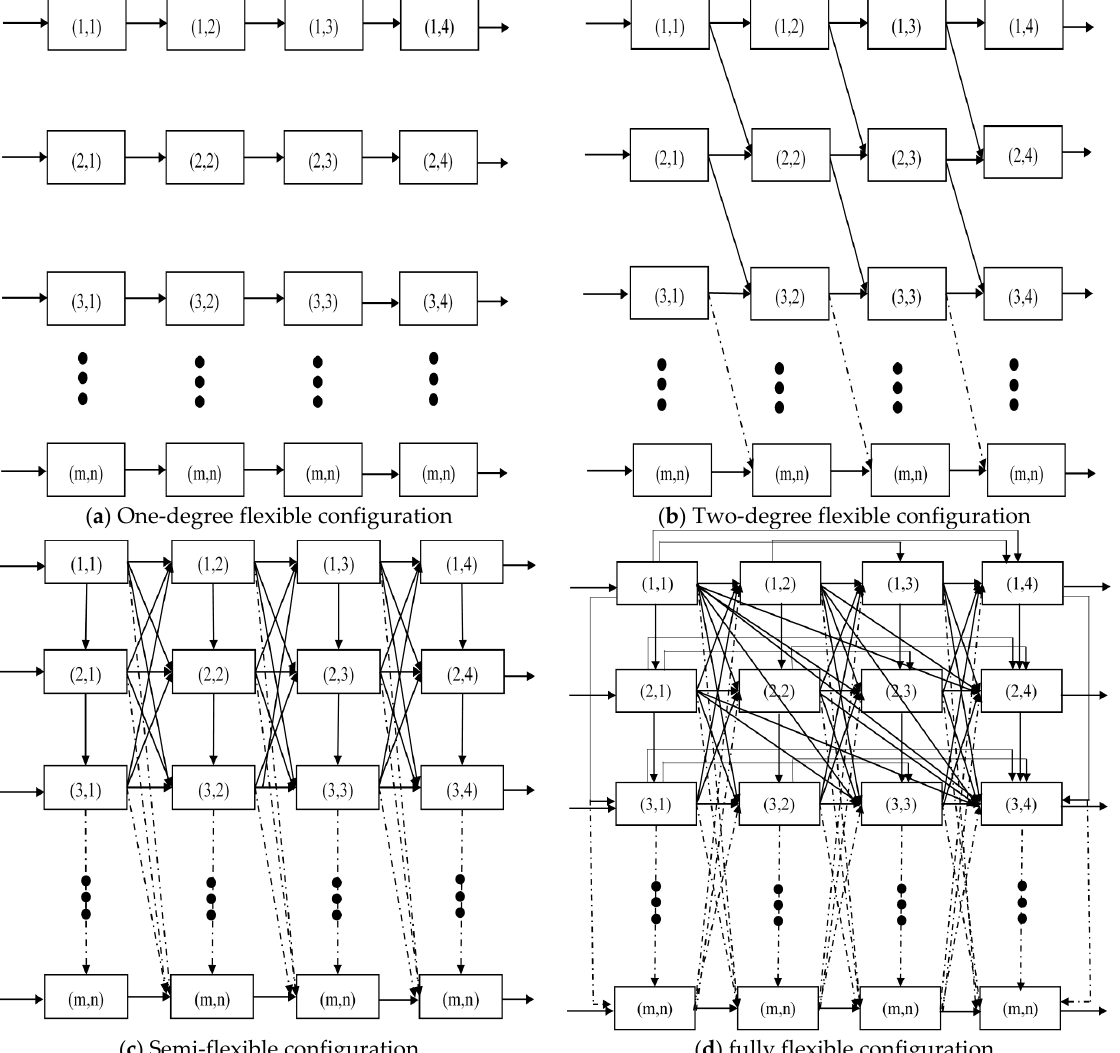
Figure 2. Flexible unit system with different configurations.